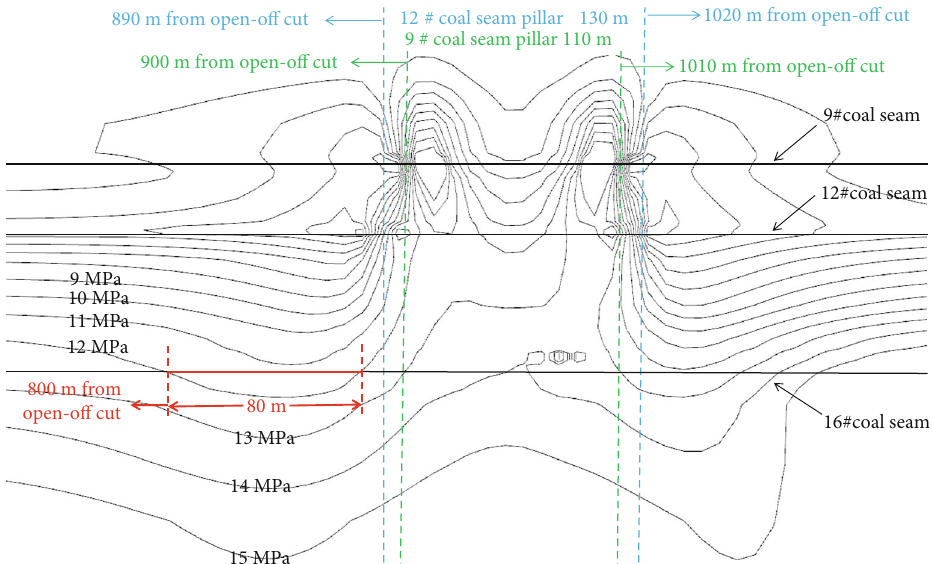
Figure 4: Vertical stress distribution curve of No. 16 coal seam under the action of the coal pillar.